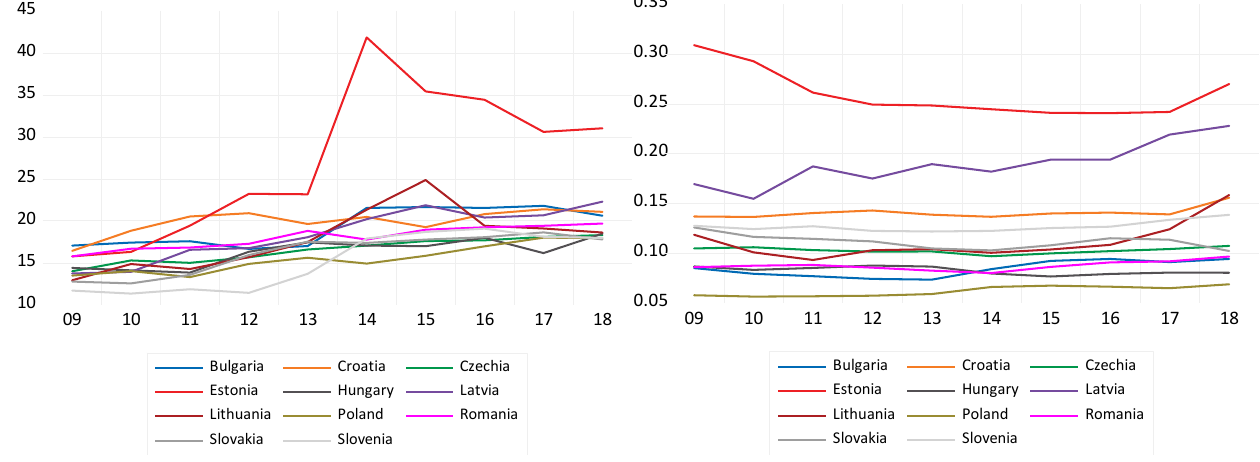
Figure 6. Solvency rate ( left panel) and Herfindahl ( right panel) in CEE countries, 1995–2018 (%). On the other end, the Herfindahl index shown in Figure 6 (right panel) indicates considerable differences between CEE countries in terms of their banking systems’ concen- tration; for example, Estonia recorded values of the index in the range of 0.24 to 0.30, while Poland recorded values between 0.05 to 0.07 over the period under scrutiny. As mentioned above, the Estonian banking system is domiated by three banks—Swedbank, SEB Bank and Luminor Bank—while the the largest local capital based bank, LVH Bank, holds 6%